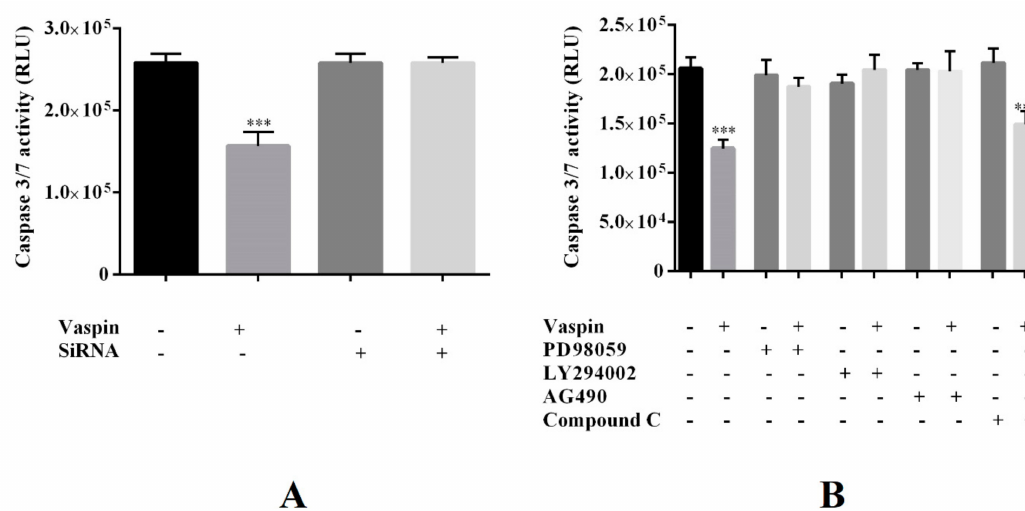
Figure 6. Involvement of the GRP78 receptor ( A ) and MAP3 / 1, AKT, STAT3, and PRKAA1 kinases ( B ) in vaspin-mediated Gc apoptosis: Cells were pretreated with GRP78 siRNA (2 nM) for 24 h or were treated for 1 h with the following MAP3 / 1, AKT, STAT3, and PRKAA1 kinase inhibitors: PD098059 (5 µ M), LY294002 (10 µ M), AG490 (50 µ M), and Compound C (1 µ M). Vaspin (1 ng / mL) was added for 24 h. Caspase-3 and -7 activities were analyzed using the Caspase-Glo 3 / 7 assay. Experiments were independently performed and repeated five times ( n = 5). Data are plotted as the means ± SEM. Significant di ff erences between control and vaspin treatments or inhibitor and vaspin + inhibitors treatment are indicated by *** p < 0.001; Control (C), Relative Luminescence Unit